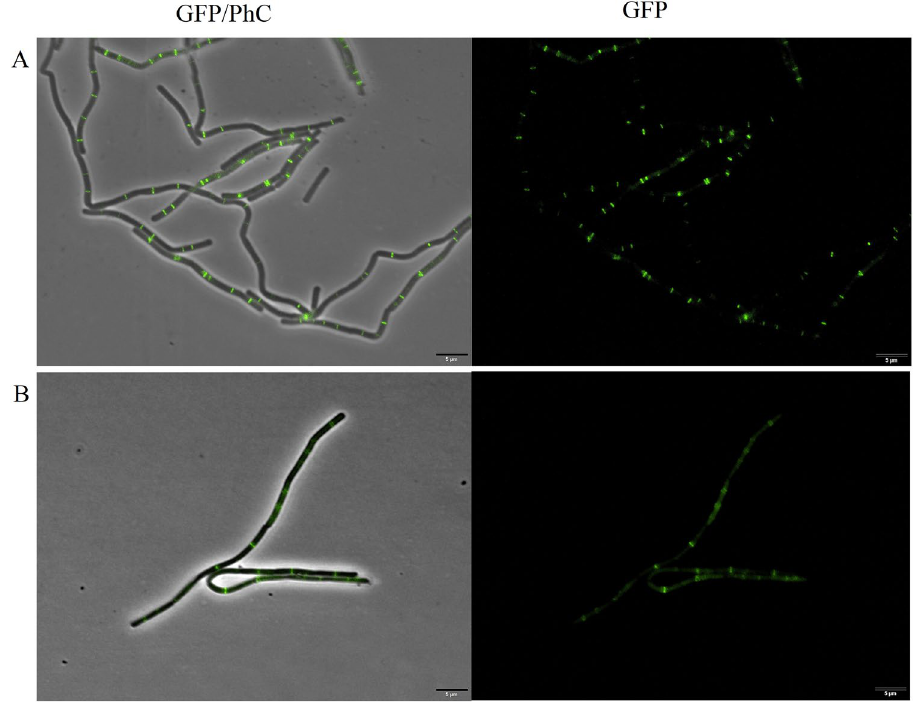
cells per mL −1 . ( B ) Cells after 15 min of exposure to ZnO NPs in the IC 100 . GFP/PhC is the phase contrast images superimposed on the GFP fluorescence images. Scale bar 5 μm; × 100